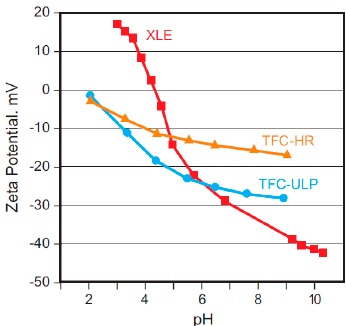
Figure 4. Zeta potentials for three polyamide RO membranes as a function of pH when immersed in a 10 mM solution of sodium chloride. Membranes tested include a high-rejection type (thin composite (TFC)-HR, Koch Membrane Systems, Wilmington, MA, USA), a low-energy type (XLE, DuPont-FilmTec), and an ultra-low-pressure type (TFC-ULP, Koch Membrane Systems). XLE membrane tested at 25 ◦ C (temperature for other membranes tested was not reported). Used with Permission from Elsevier B.V.